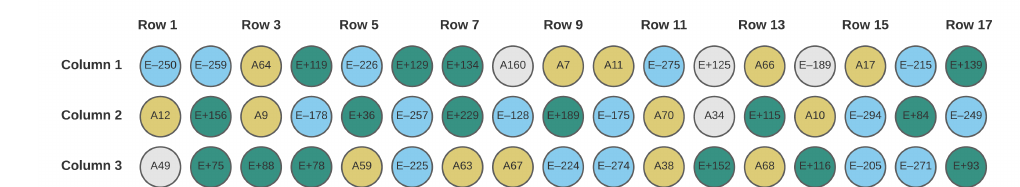
Figure 1. Field site layout. Plants were established in the field 30 June 2011. They were sampled for this experiment in 2017 and 2018. E − (blue) denotes plants with no Epichloë endophytes, E + (green) denotes plants infected with the common toxic strain of E. coenophiala , and A (yellow) denotes plants infected with the AR542 strain of E. coenophiala (sold commercially as MaxQ). Grey circles indicate plants which died or were removed from analysis (see Methods for details).